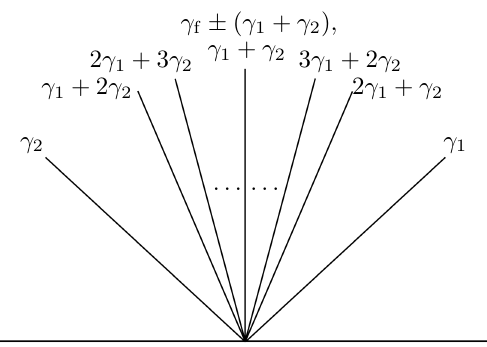
Figure 7 . Charge rays Z ( γ ; u ) of the BPS spectrum in the upper half-plane for u the first two members of the infinite families γ 1 + k ( γ 1 + γ 2 ) and γ 2 + k ( γ 1 + γ 2 ) . ideal triangulations involved on the ultraviolet curve C to gain an understanding of how the states correspond to cycles on the Seiberg-Witten curve Σ u ; m